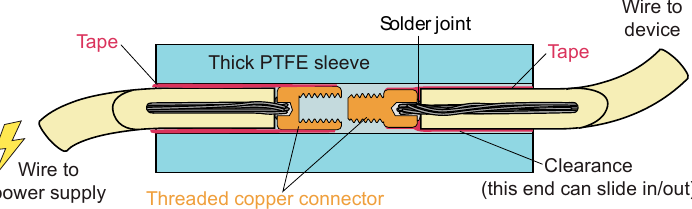
Figure A7. Cross-sections of a high voltage electrical connector. The thick PTFE sleeve was typically